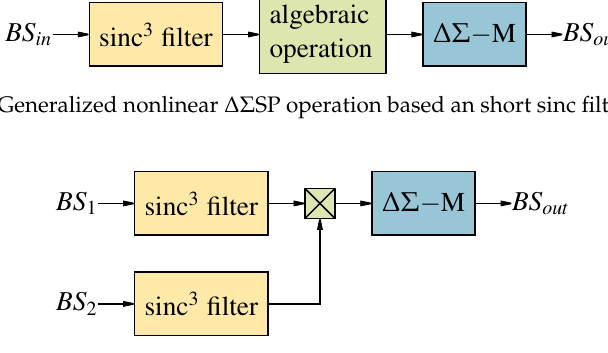
Figure 26. Multiplication of two bit-streams using sinc filters and DSP